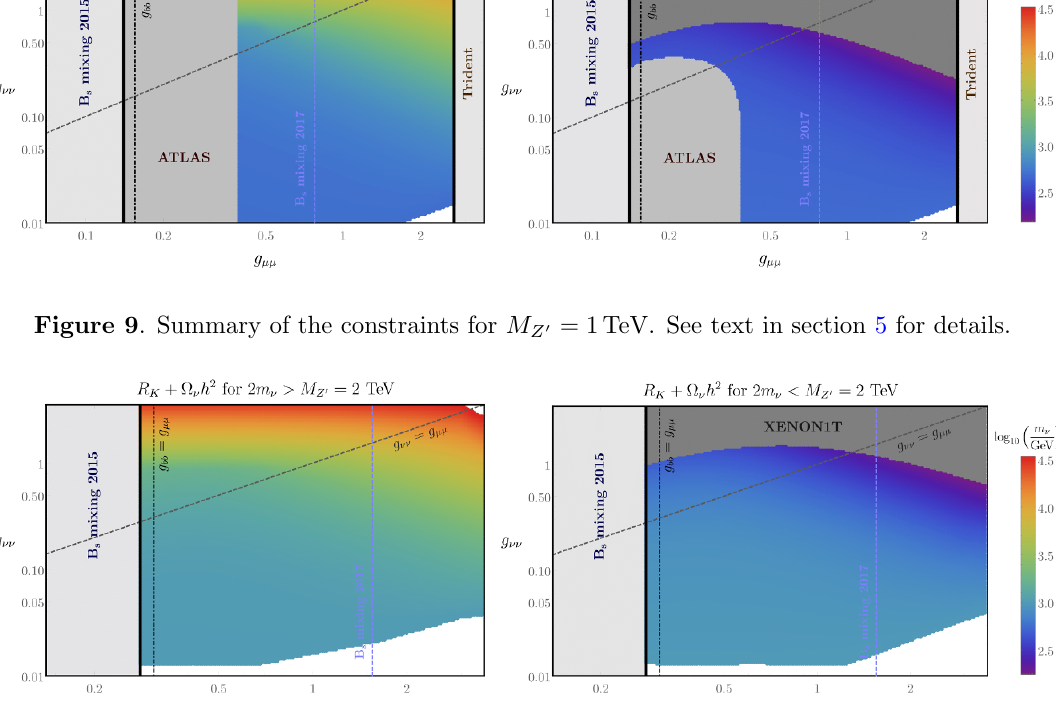
smaller (blue) to larger (red) m . The white regions are where we (cid:12)nd no parameters choice (cid:23) to tune the annihilation cross section to the thermal value. The continuously gray-shaded regions are excluded by direct detection, indirect detection, B mixing, dimuon searches s at the LHC, Z decay to four muons and/or muon trident constraints. However, we choose not to shade the region excluded by the recent update of the B mixing constraints in [56], s and instead represent those by a dashed blue line labeled \ B mixing 2017". The region s